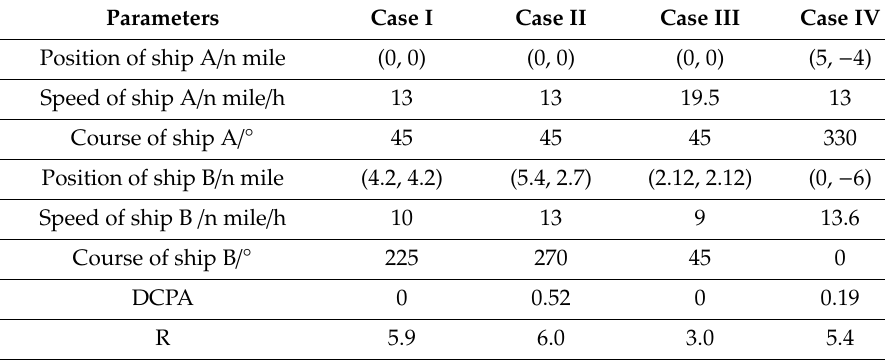
Table 3. Ship encounter information for di ff erent scenarios.